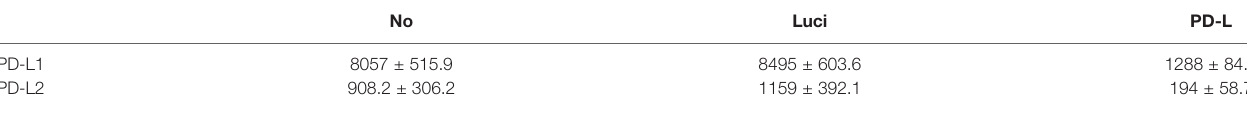
TABLE 1 | Summary of D MFI (MFI PD-L – MFI isotype ) of no siRNA IL-15 DCs (no), luciferase siRNA IL-15 DCs (luci) or PD-L siRNA IL-15 DCs (PD-L), n = 48.